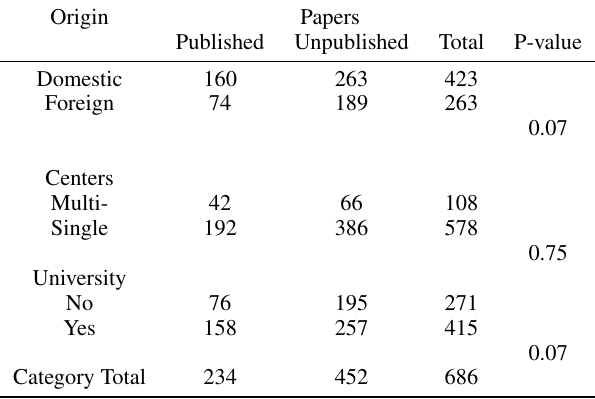
Table 2. Abstract origin and institution